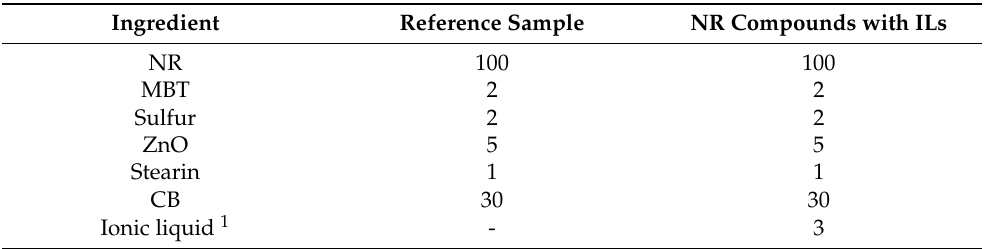
Table 2. General formula of the NR compounds, parts per hundred of rubber (phr); MBT, 2- mercaptobenzothizole, CB, carbon